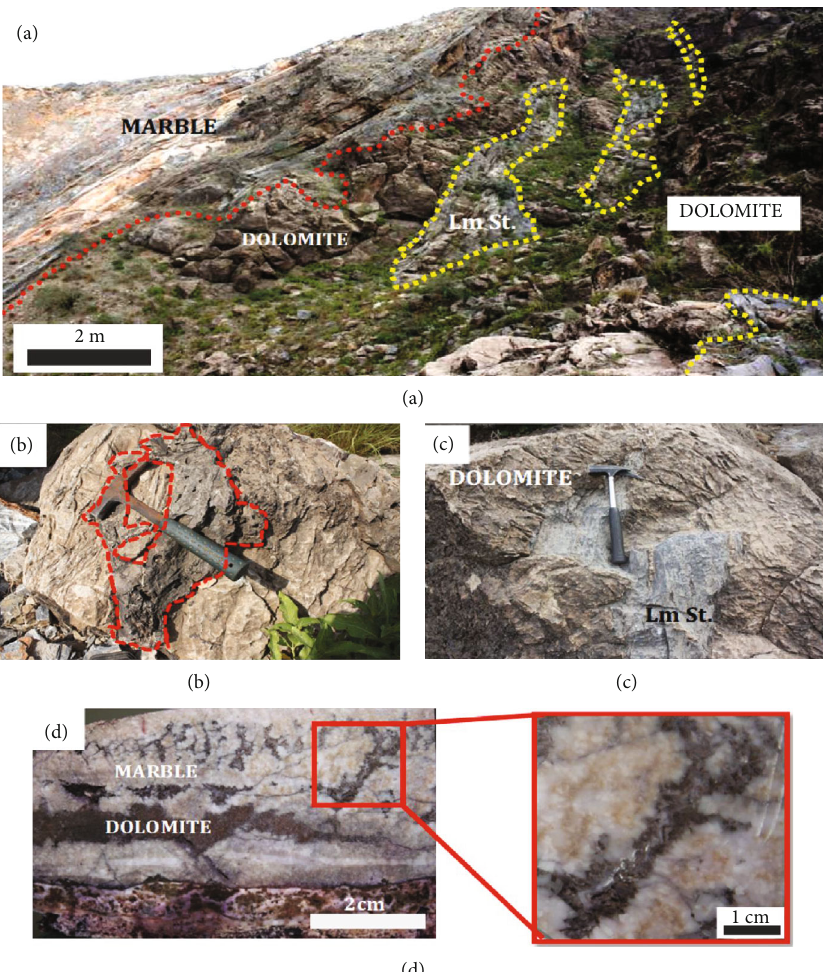
Figure 4: Field photographs of major diagenetic phases (marble, dolomites) in the study area. (a) Contact relationships between limestone/marble with igneous intrusion and dolomite. Note that isolated blocks of limestone frequently occur within the succession. (b) Black igneous dyke material in contact with medium grey dolomite. (c) Irregular contact between light grey limestone and dark brown dolomite. (d) Cut slab showing dark brown, sugary textured dolomite Dol. II in contact with light brown dolomitic marble; inset shows a close-up view of the pore- fi lling dolomite (Dol. II) and dolomitic marble (DM). Lm St: